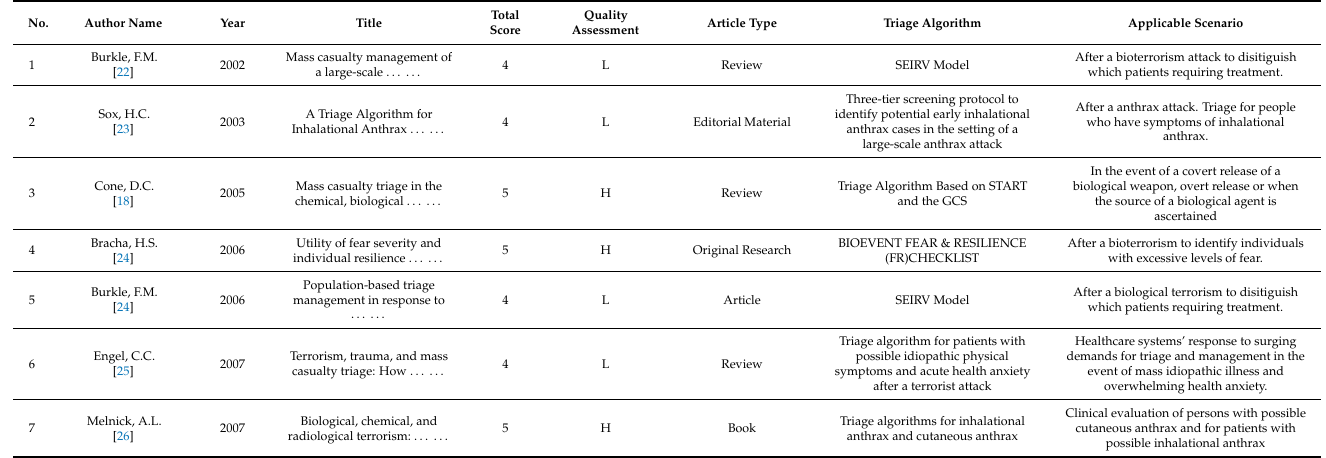
Table 2. Quality assessment (QA) of the included